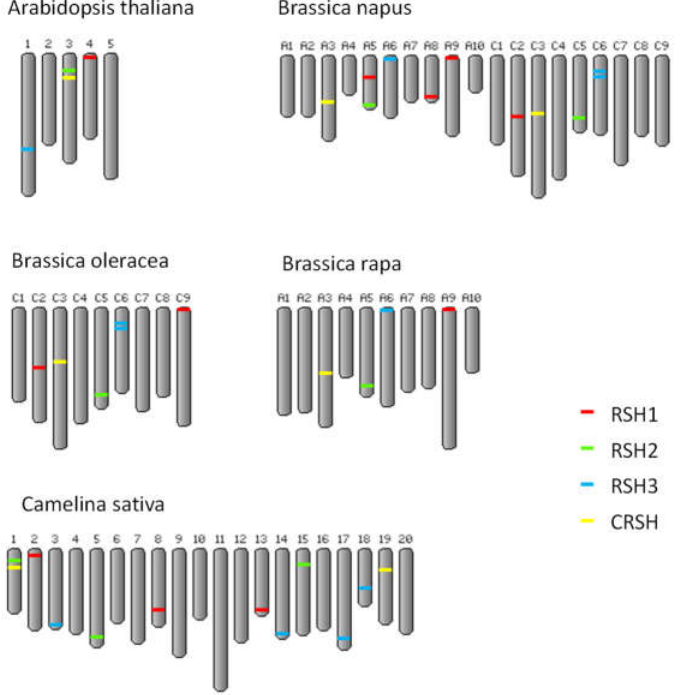
Figure 1. Chromosomal localization of RSH genes in A. thaliana , B. napus , B. oleracea , B. rapa and C. sativa .